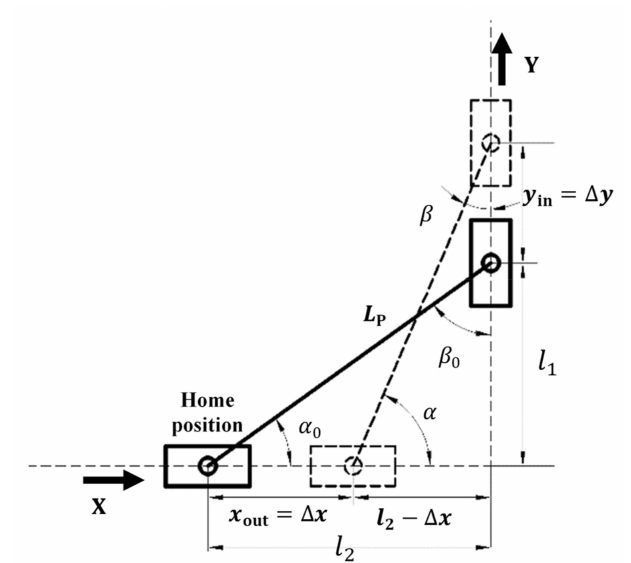
Figure 4 Kinematic representation of the double-slider mechanism. Figure 4. Kinematic representation of the double-slider mechanism.